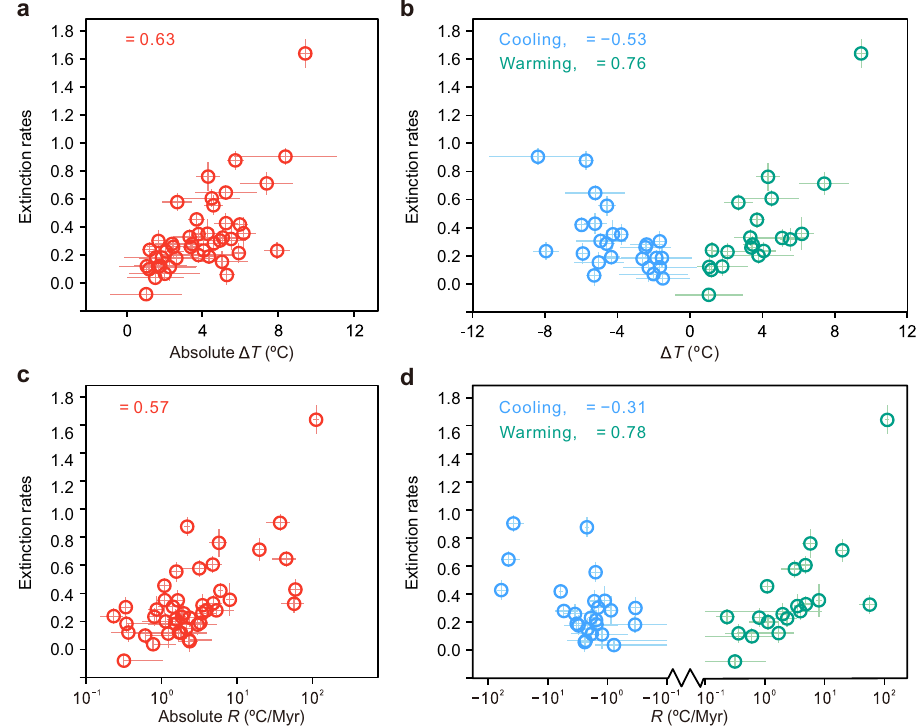
Fig. 2 The relationship between climate change and GF extinction rate. a Cross plot of Δ T and extinction rate ( n = 45, ρ = 0.63, P < 0.001). After excluding the Big Five extinctions, the correlation persists ( n = 40, ρ = 0.54, P < 0.001). b Cross plot of Δ T and extinction rate, with blue dots representing cooling events ( n = 25, ρ = − 0.53, P = 0.006), and green dots representing warming events ( n = 20, ρ = 0.76, P < 0.001). c Cross plot of R and extinction rate ( n = 45, ρ = 0.57, P < 0.001). After excluding the Big Five extinctions, the correlation persists ( n = 40, ρ = 0.42, P = 0.007). d Cross plot of R and extinction rate, with blue dots representing cooling events ( n = 25, ρ = − 0.31, P = 0.134), and green dots representing warming events ( n = 20, ρ = 0.78, P < 0.001). n = the sample size used to derive statistics. Horizontal and vertical bars show mean ±1 x standard deviation (see Methods). Red, blue, and dark cyan dots represent all, cooling events and warming events, respectively. The statistical test was two-sided and no adjustments were made for multiple comparisons. Source data are provided as a Source Data fi le.